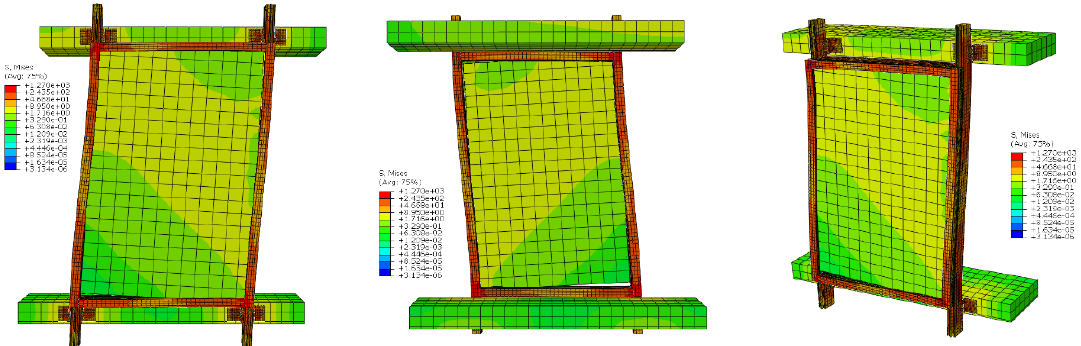
Figure 36. Deformation of weak areas when linear guide length of 50 mm is applied.